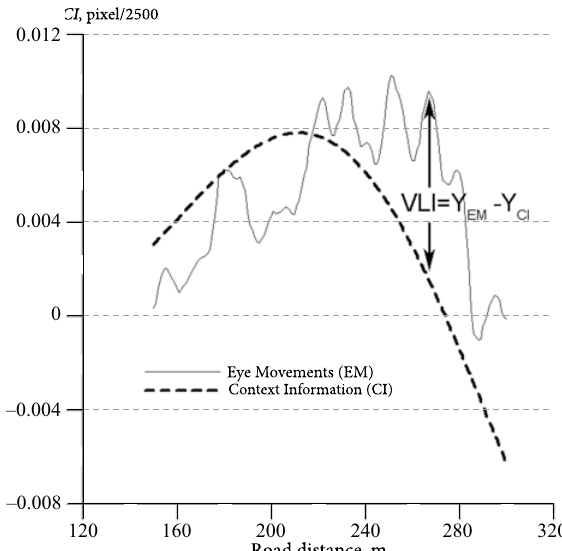
Fig. 3. Determination of VLI as the difference between the EM and CI